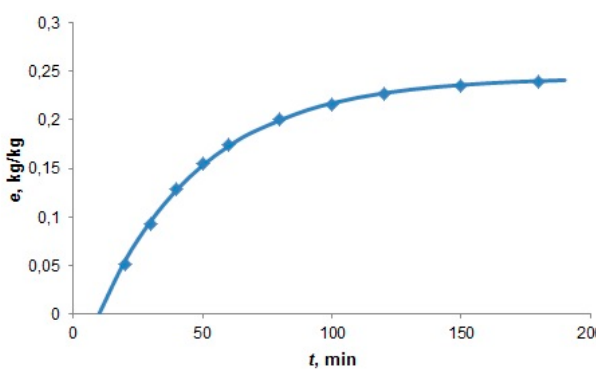
Figure 7. Extraction yield from Chlorella protothecoides [17] ( N = 1 g, t r = 34 min). Model parameters: x u = 0.244 kg·kg − 1 , K = 0.20 kg·kg − 1 , n = 1. x u = 0.244 kg ¨ kg ´ 1 , K = 0.20 kg ¨ kg ´ 1 , n =